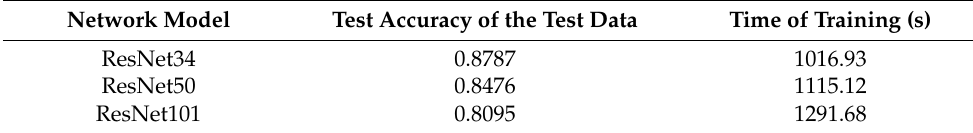
Figure 2. Experimental results for ResNet models: ( a ) training set loss; ( b ) validation set accuracy. Table 1. Results of Resnet network with different depths.